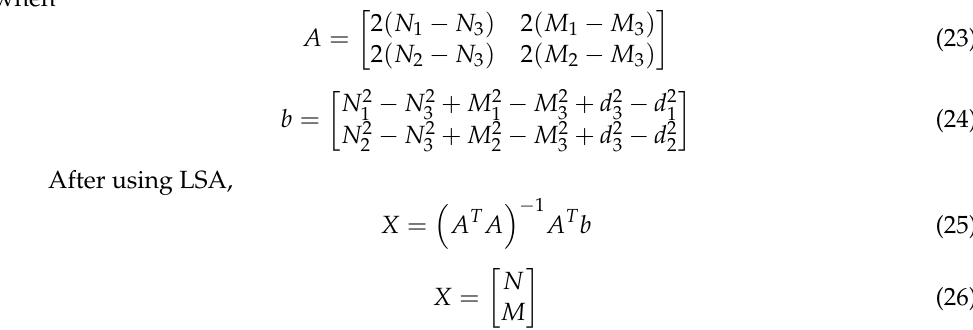
Figure 13. Zoomed comparison of different algorithm results in the UWB field experiment. In this section, the UWB localization system has been investigated. Three anchors and one tag have been set up in the testbed. The different anchor may have different man- ufactory errors. An individual calibration process has been applied. The field experiment can be described as dynamic research and a developed LSA-based CFKF error modelling is used to determine the distance and coordinate of the moving object. According to the results displayed in Table 3, when the experiment uses anchor 1, the uncertainty rate from the measurement results is 4.5%, the uncertainty rate from the KF results is 2.4%, and the error rate from the CFKF error modelling algorithm results is 1.9%. The uncertainty rate from the KF results is higher than the CFKF error modelling algorithm results. Therefore, the CFKF error modelling algorithm results are about 2.6% more accurate than the results from the measurement, and are 0.5% more accurate than the results from the KF. For an- chor 2, the uncertainty rates are as follows: measurement (3.7%), KF (2.1%) and CFKF er- ror modelling algorithm (1.7%). For anchor 3, the uncertainty rates are as follows: meas- urement (3.2%), KF (1.5%) and CFKF error modelling algorithm (0.6%). For the field ex- periment, the uncertainty rates are recorded in Table 4 and are as follows: measurement (2%–20%), KF (2%–10%) and CFKF error modelling algorithm (1%–2%). According to all